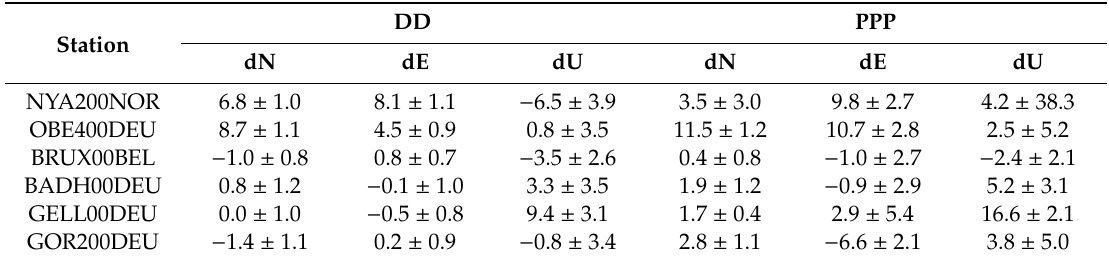
Table A4. Coordinate di ff erences between solution E2 and G1 (E2 minus G1) and their standard deviations. All values in